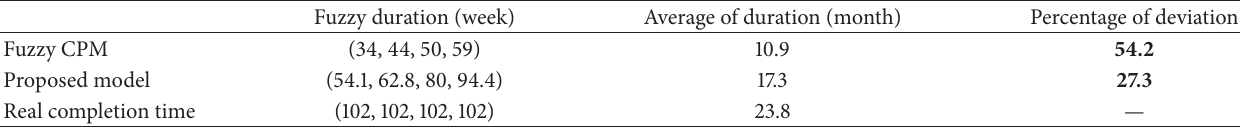
Table 6: Comparative results and percentage of deviation.